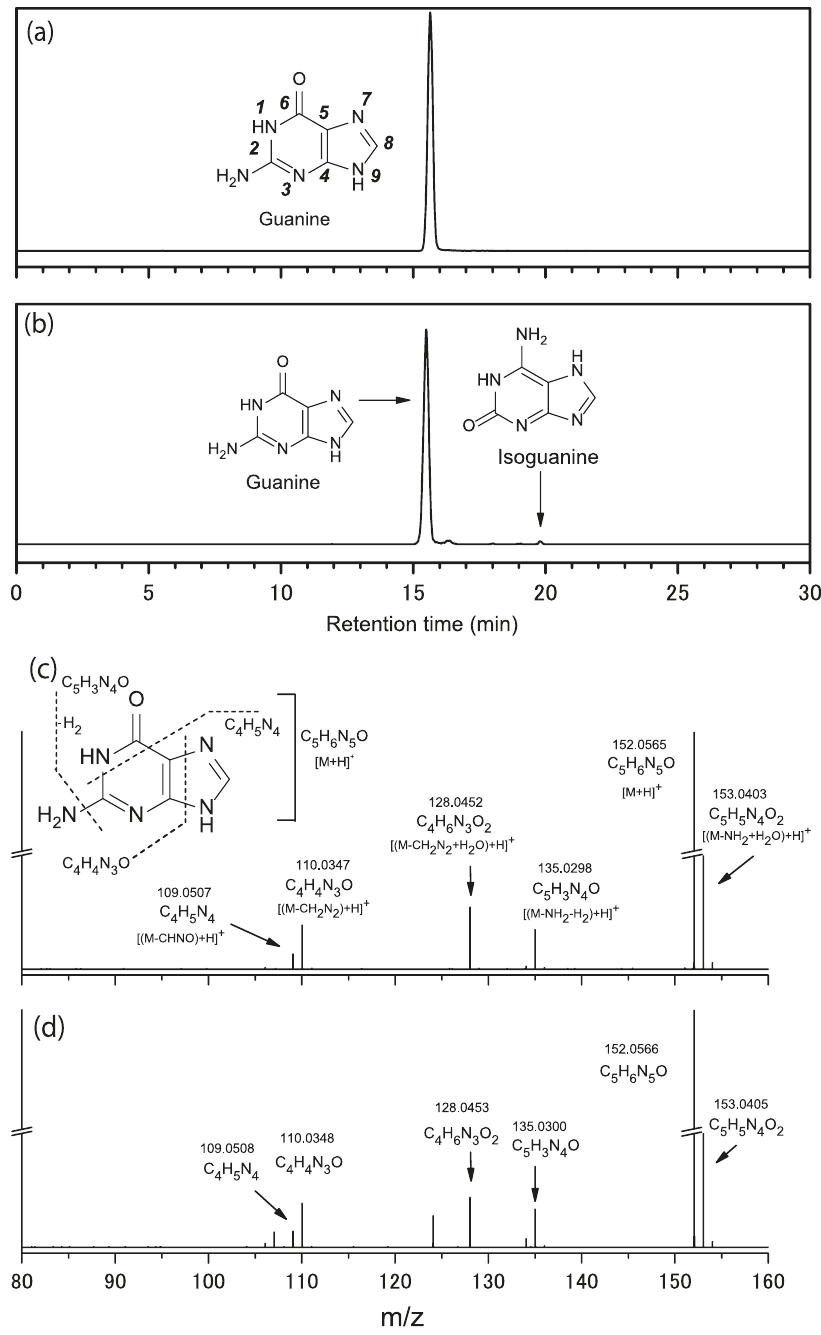
Fig. 1 Detection of purine nucleobases. Mass chromatograms at m/z = 152.0567 within a 3 ppm exact mass window at the monoisotopic mass for a the guanine (0.21 ng) standard reagent (STD) and b Murchison #1 extract were measured using an InertSustain PFP column. Additionally, isoguanine, a structural isomer of guanine, was detected in the Murchison #1 extract. Mass fragmentation patterns of c guanine STD and d guanine were detected in the Murchison #1 extract measured by MS/MS experiments. Note: “ exact mass ” , representing a theoretical value obtained by calculation, is different from “ accurate mass ” , which is a measured value with a high-resolution mass spectrometer. Bold italic numbers in panel a represent the numbering of atoms in the chemical structures of purine